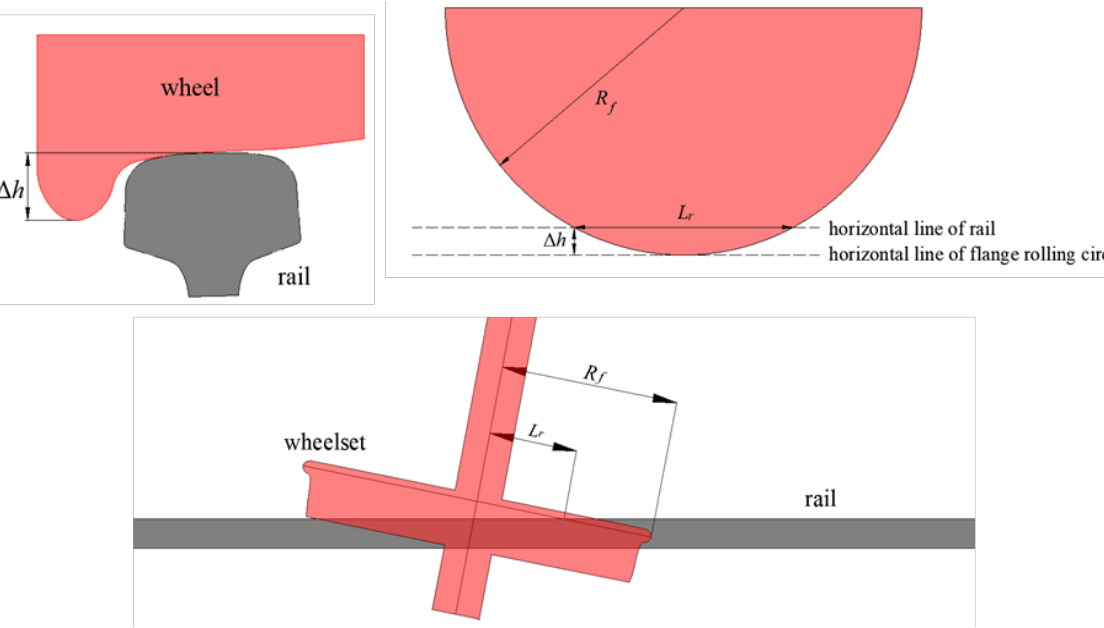
Figure 5. Relationship between the height difference between the top of the wheel flange to the top surface of the rail ∆ h and the twisting of the wheelset.